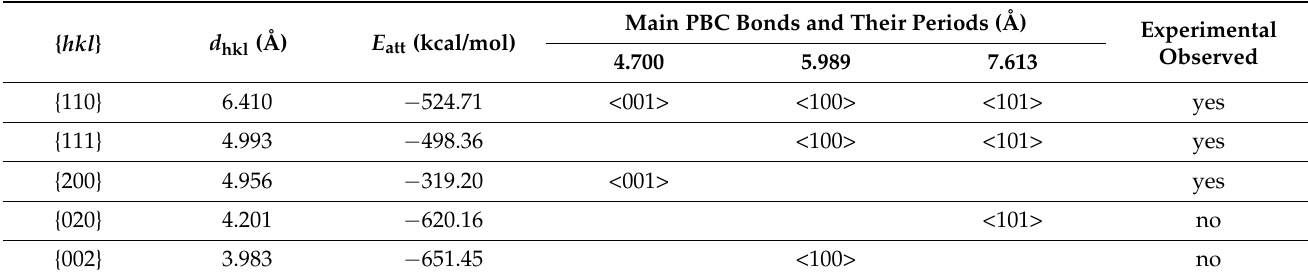
Table 1. Miller faces { hkl } on a CBOF crystal, their attachment energies E att , the interplanar distances d hkl , and periodic PBC chains parallel to them as well as the observed miller faces in the experiments.